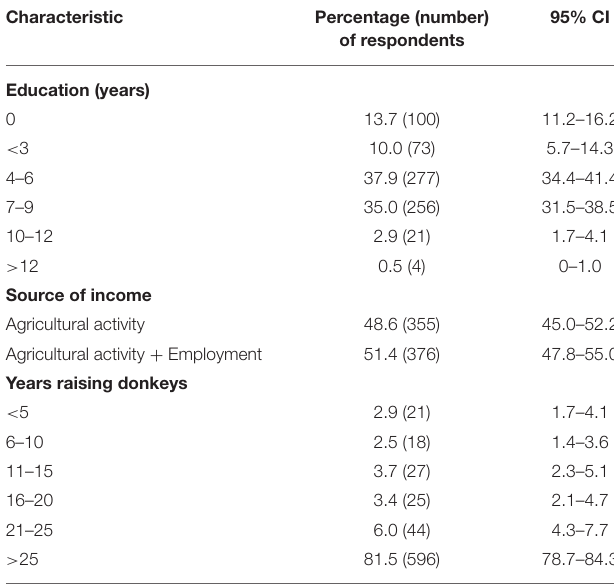
TABLE 1 | Respondents (Donkey owners)’ number of years of education, source of income, and years raising donkeys in Western Liaoning and Eastern Inner Mongolia of China ( n = 731).